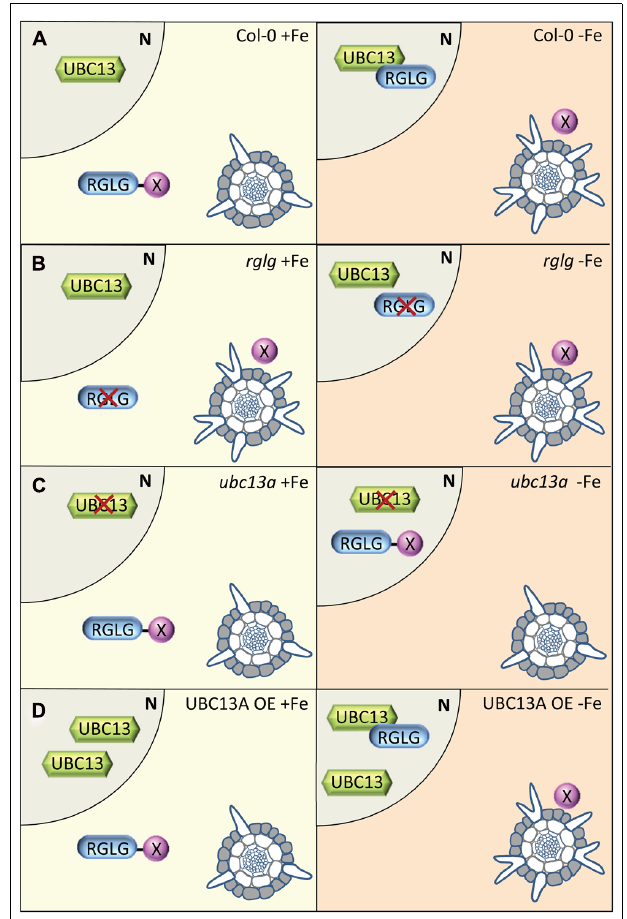
FIGURE 1 | Model depicting putative interactions of UBC13 and RGLG proteins and their effects on root hair differentiation. (A) In wild-type roots, protein X is bound to RGLG proteins, preventing the formation of branched root hairs. UBC13 is present, but only under iron-deficient conditions UBC13 interacts with RGLG proteins which move to the nucleus.The interaction of UBC13 with RGLG1/2 releases protein X which leads to the formation of branched hairs. (B) In rglg mutants, protein X is free both in the presence and absence of iron, causing root hairs to branch independent on the iron supply. (C) In root hair cells of ubc13 plants, no interaction between UBC13 and RGLG1/2 can occur, leaving protein X inactive under both iron-sufficient and iron-deficient conditions. (D) Over- expression of UBC13 increases the level of UBC13 protein but does not affect UBC13-RGLG1/2 interaction, resulting in a phenotype similar to that of the wild